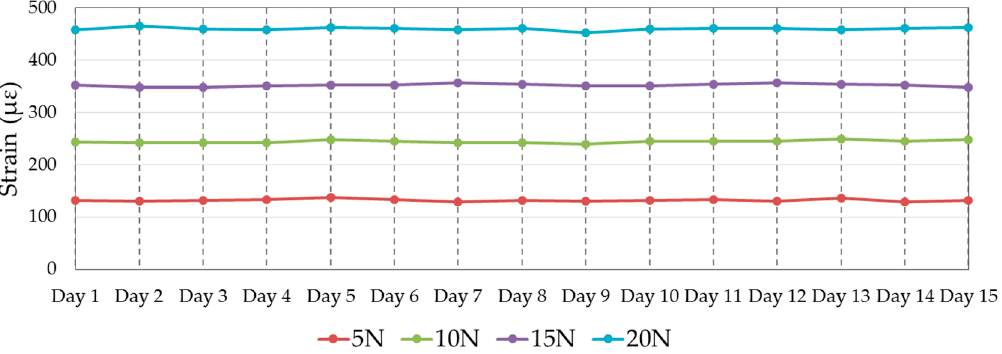
Figure 11. Strain values measured by the FBG sensor under different weights on different days.